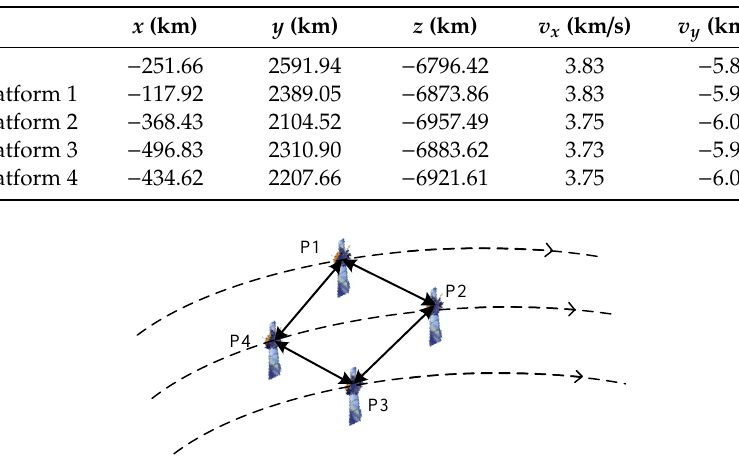
Figure 1. The communication network among the observation platforms. Table 1. The initial condition of parameters in the simulation.